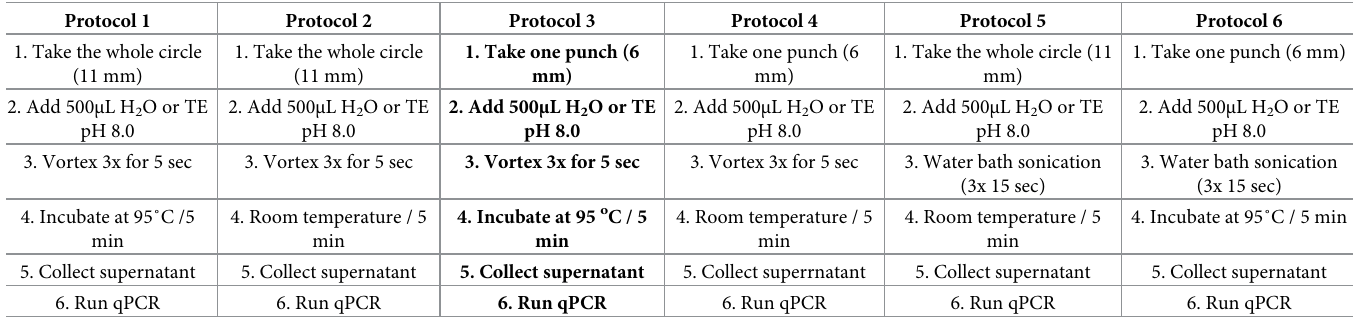
Table 2. Steps of each of the six different DNA elution protocols evaluated in the present work. Protocol